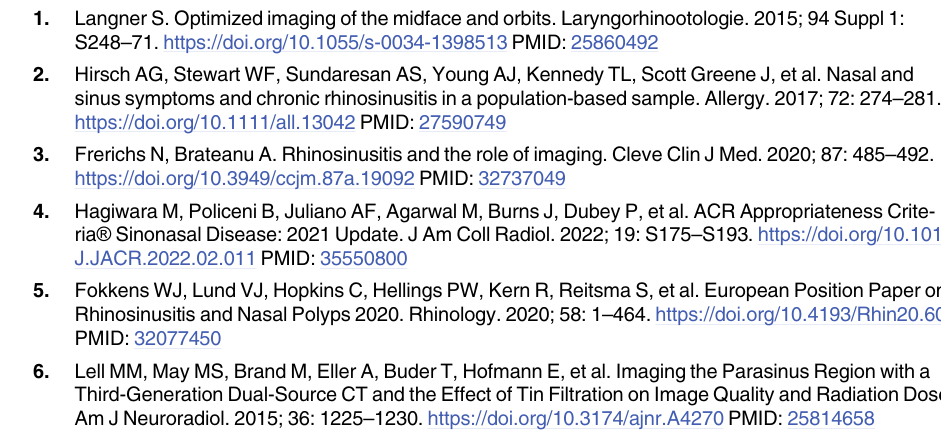
S1 Fig. Example of ROI measurements in a CT image of the Alderson phantom for objec- tive image evaluation. The yellow, purple and red circles represent representative ROI mea- surement positions for air, soft tissue and bone structures,